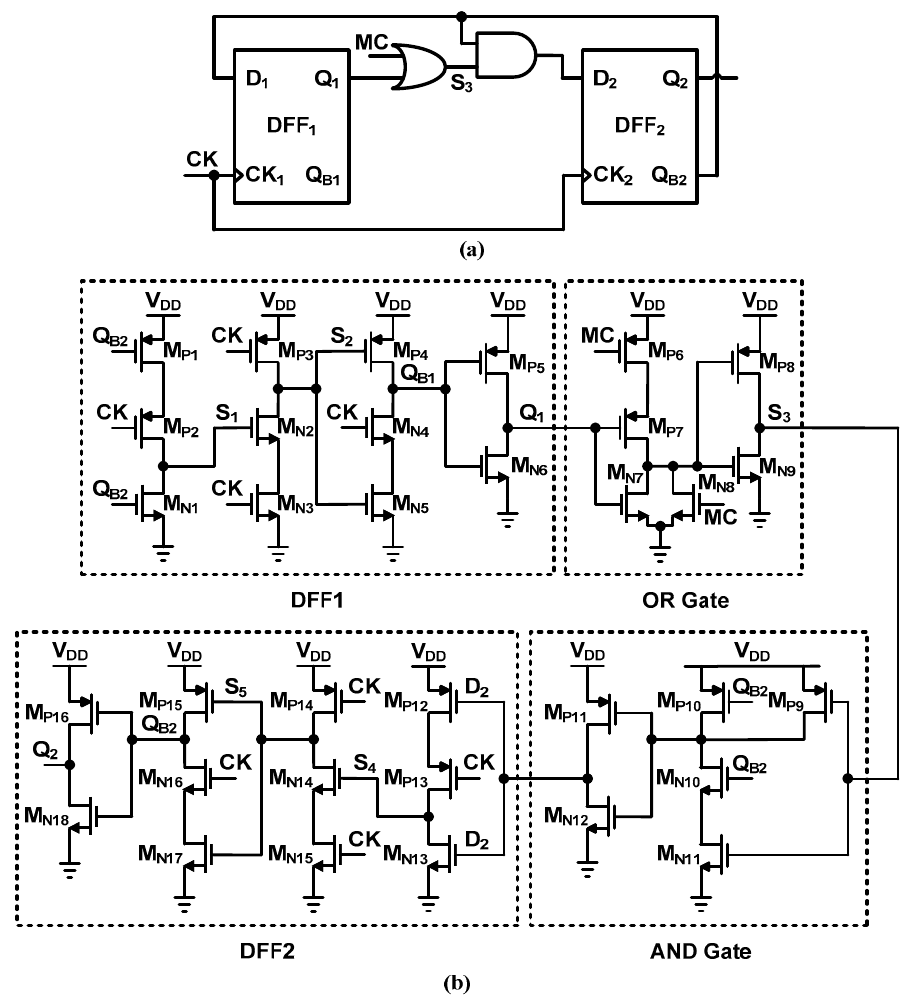
Figure 1. ( a ) Block diagram and ( b ) schematic of the conventional true-single-phase-clock (TSPC) divide-by-2/3 prescaler.